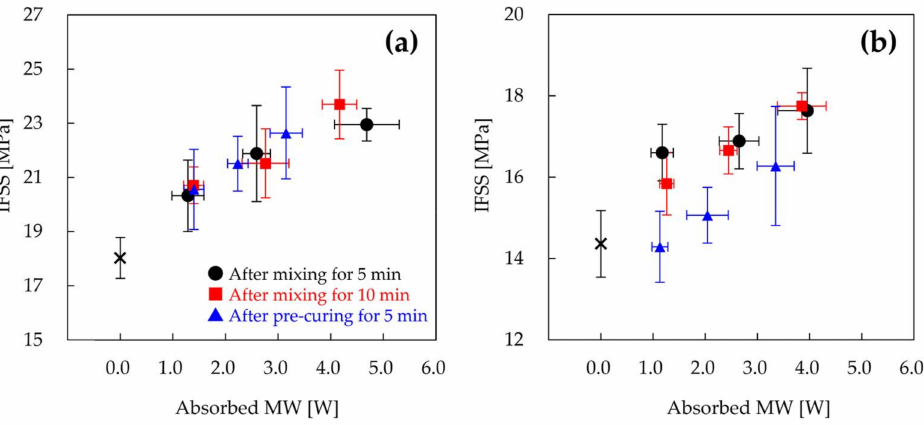
Figure 6. IFSSs of samples prepared with rCF-500 ( a ) and rCF-600 ( b ). The samples were MW-irradiated for 5 min (black circle) or 10 min (red square) after mixing the epoxy resin and curing agent. The sample was MW-irradiated after pre-curing at 23 ◦ C for 24 h (blue